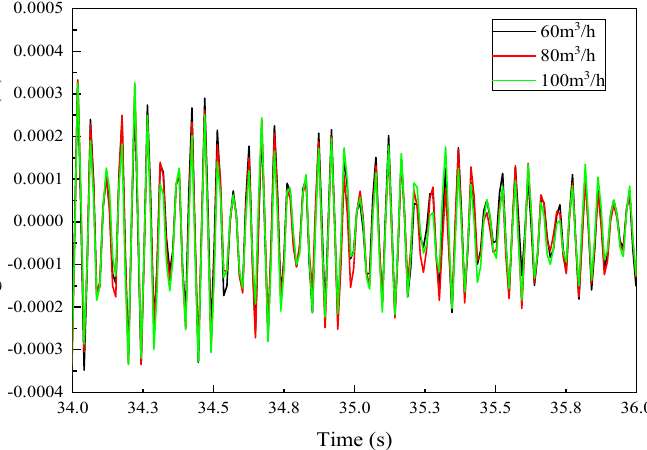
Figure 13. Longitudinal deformation variation of the inner leaching tubing with different water injection rates.